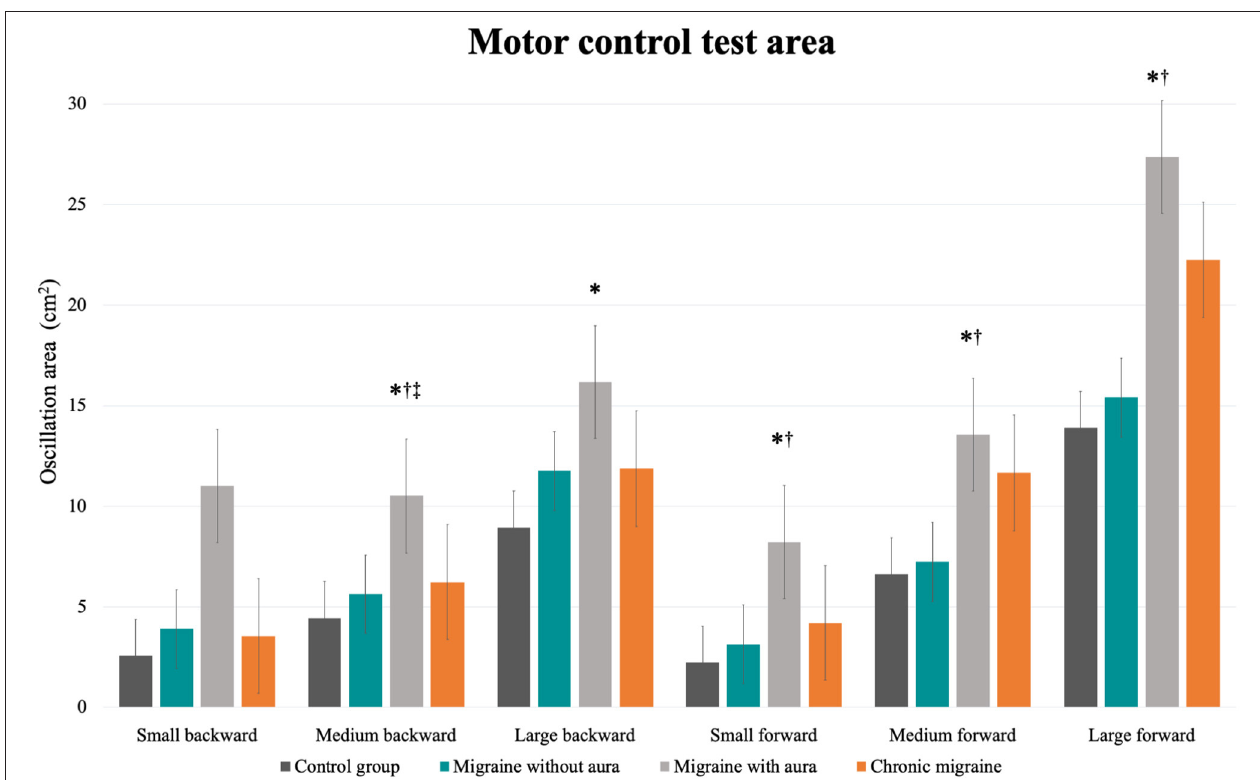
FIGURE 1 | Mean and standard errors of the oscillation area (cm 2 ) of each condition of the motor control test among patients with migraine with and without aura, chronic migraine, and controls. * p < 0.01 vs. control group; † p < 0.04 vs. migraine without aura; ‡ p = 0.03 vs. chronic migraine.